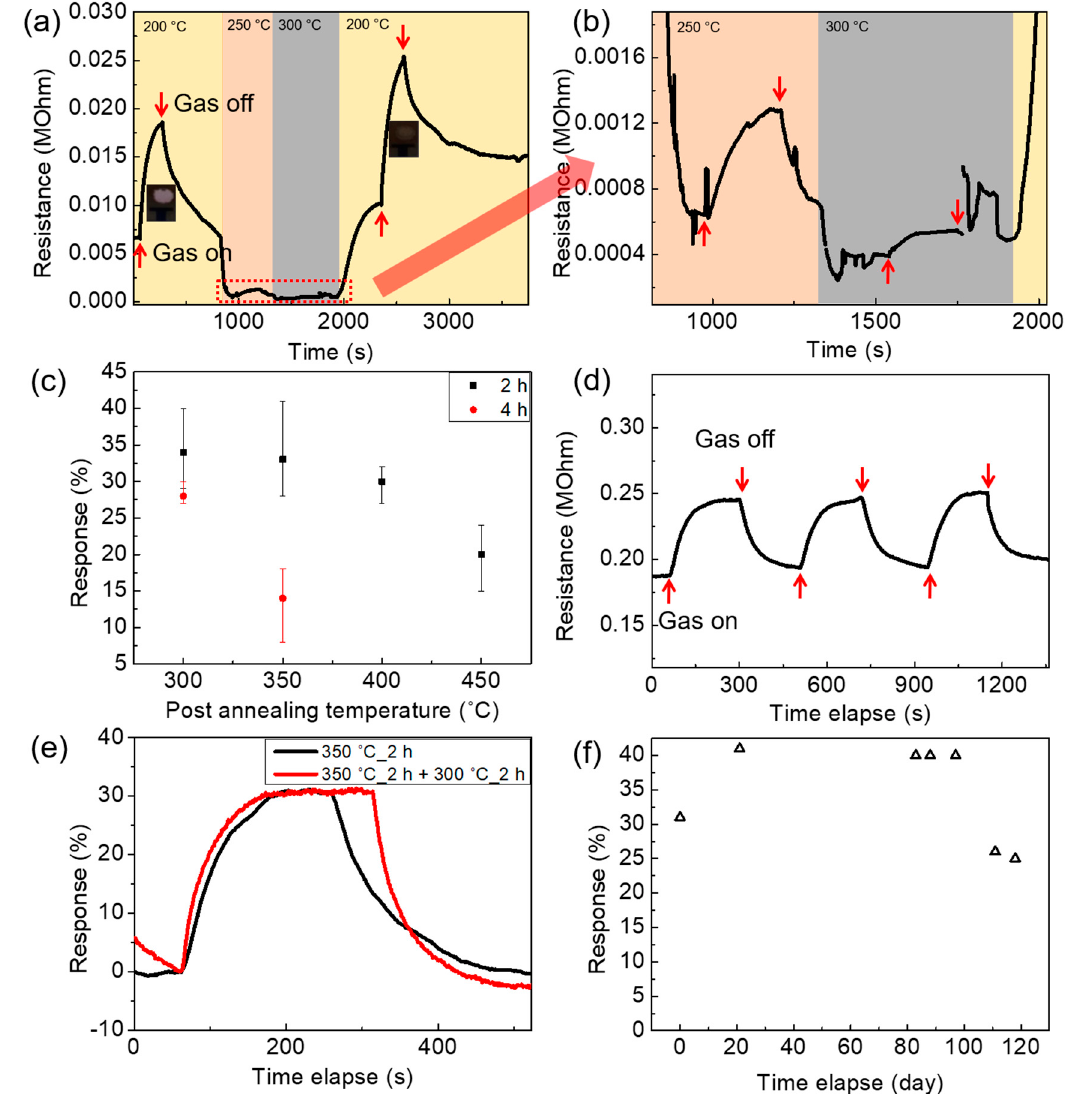
Figure 9. ( a , b ) Dynamic sensing characteristics upon changes of applied temperature toward 4.5 ppm of acetone gas. ( c ) Responses of annealed Co(OH) x F 2 − x nanosheet sensors with various post-annealing conditions. Dynamic sensing characteristics of the sample after post-annealing at 350 °C for 2 h ( d ) and after additional annealing at 300 °C for 2 h ( e ). ( f ) Long-term stability test of the 350 °C sample for 118 days toward 4.5 ppm of acetone gas at 300 °C.